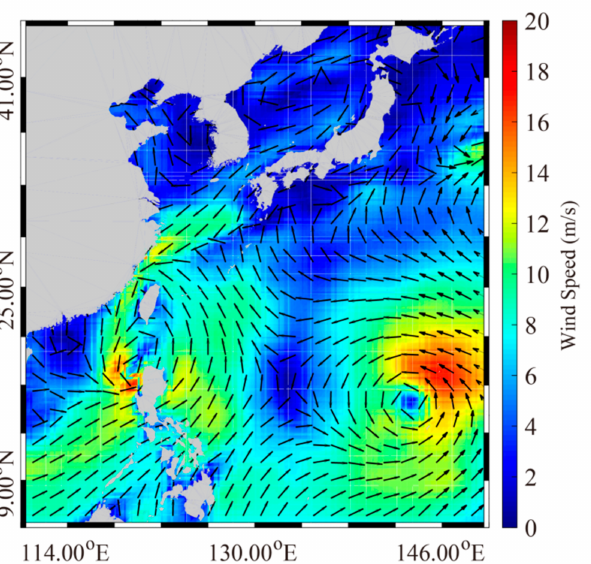
Figure 2. The wind map for Typhoons Chan-hom and Linfa at 18:00 UTC on 5 July 2015. Wind maps were composited using the European Centre for Medium-Range Weather Forecasts (ECMWF) wind data and a parametric Holland model